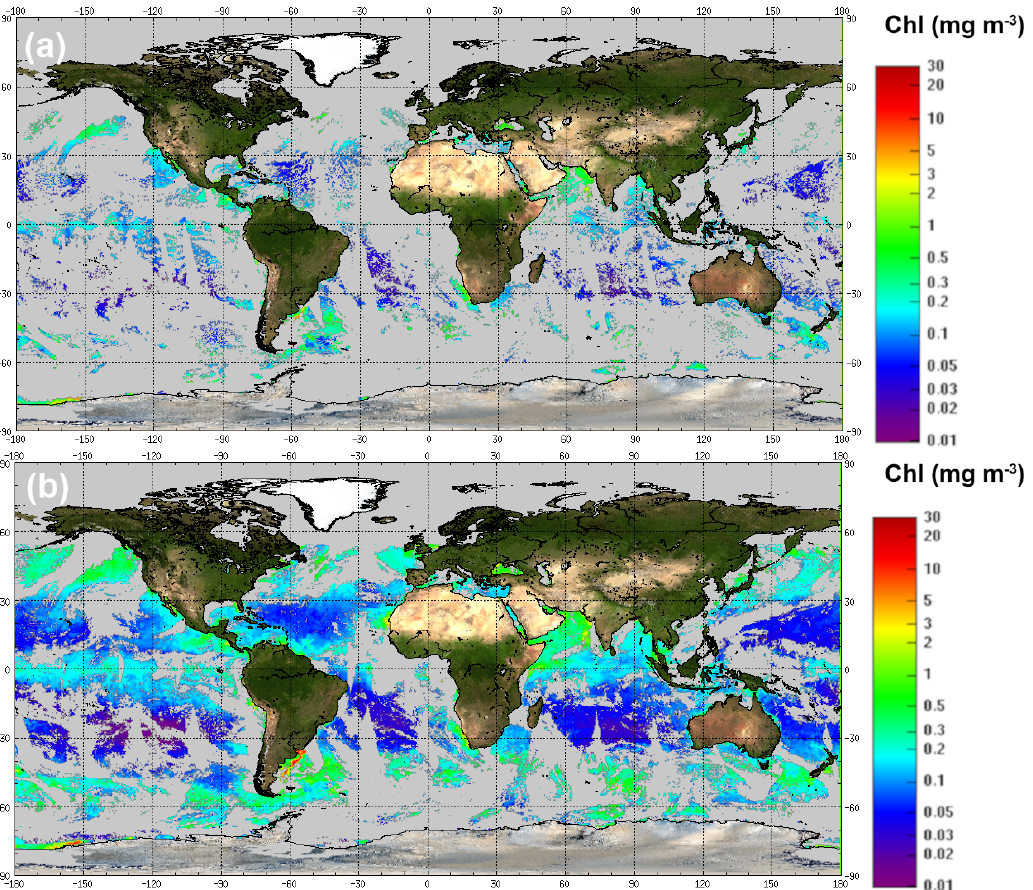
Figure 8. The chlorophyll a concentration (15 December 2017) for (a) the OC-CCI level 3 product and (b) the GlobColour product. The two initiatives used MODIS Aqua, and VIIRS-SNPP at this time, while OLCI-S3A was also used by GlobColour products.